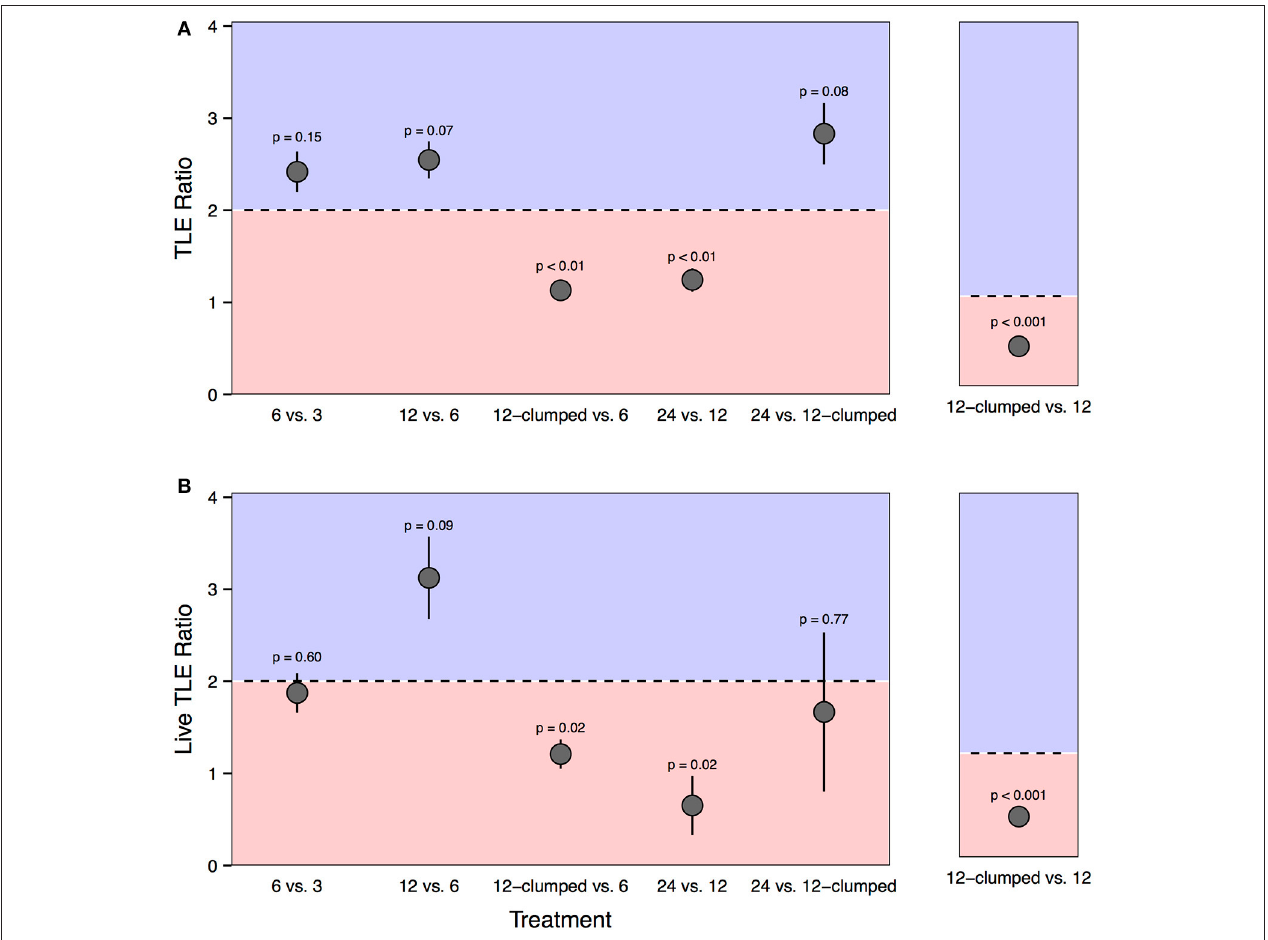
FIGURE 8 | Ratios comparing final plot level (A) TLE and (B) live TLE between treatments differing in coral density. Comparisons are either between treatments that differ two-fold in coral density (e.g., 6-colony vs. 3 colony treatments; left panels) or with equal densities (12-clumped vs. 12-colony treatments; right panels). The black dotted line represents the expected 2:1 (right panels) or 1:1 ratio (left panels). Points that fall within the blue shaded area exceeded expectations of habitat production and suggest positive density dependence. Points that fall within the red shaded area produced less habitat than predicted and suggest negative density